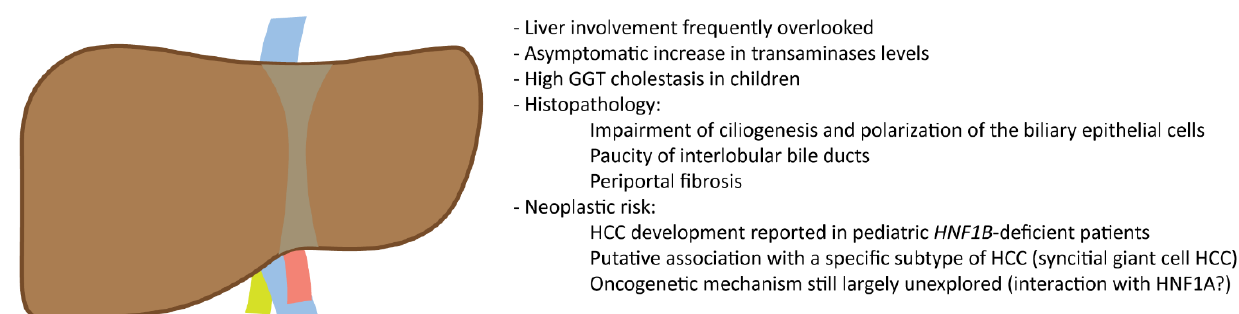
Figure 2. The HNF1B deficiency and the liver.